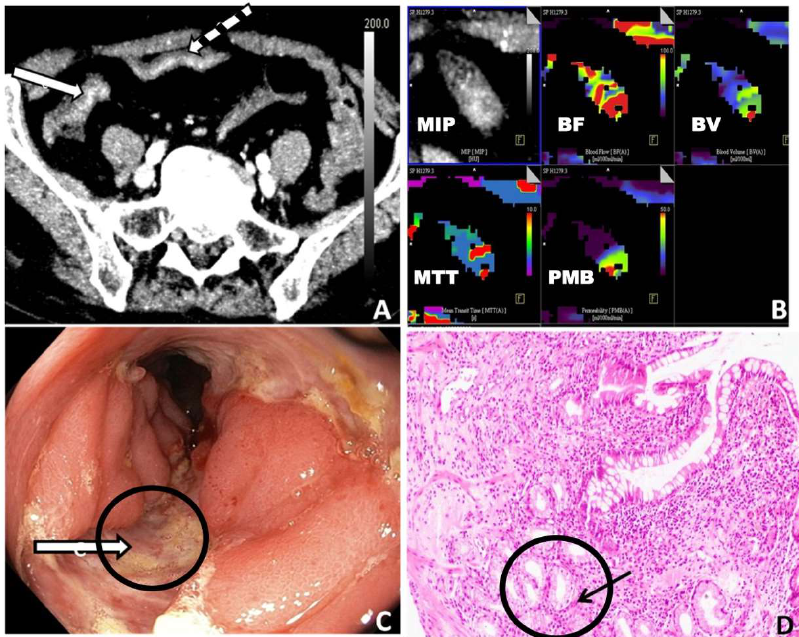
Figure 3. Case of Crohn’s disease. ( A ) Axial section from the perfusion CT base image showing enhancing mural thickening of the terminal ileum (white arrow with black striations) and caecum (white arrow). ( B ) Corresponding color-coded perfusion maps showing MIP, BF, BV, MTT, and PMB images. ( C ) Colonoscopic image of the same patient showing deep serpiginous ulcers (marked with a circle and an arrow). ( D ) Histopathological findings of the same patient: ileal mucosal biopsy shows an excess of mononuclear inflammatory cells admixed with eosinophils in the lamina propria along with foci of pyloric metaplasia (marked with a circle and an arrow) (H&E X200) (MIP: maximum intensity projection; BF: blood flow; BV: blood volume; MTT: mean transit time; PMB: permeability; H&E: haematoxylin and eosin).